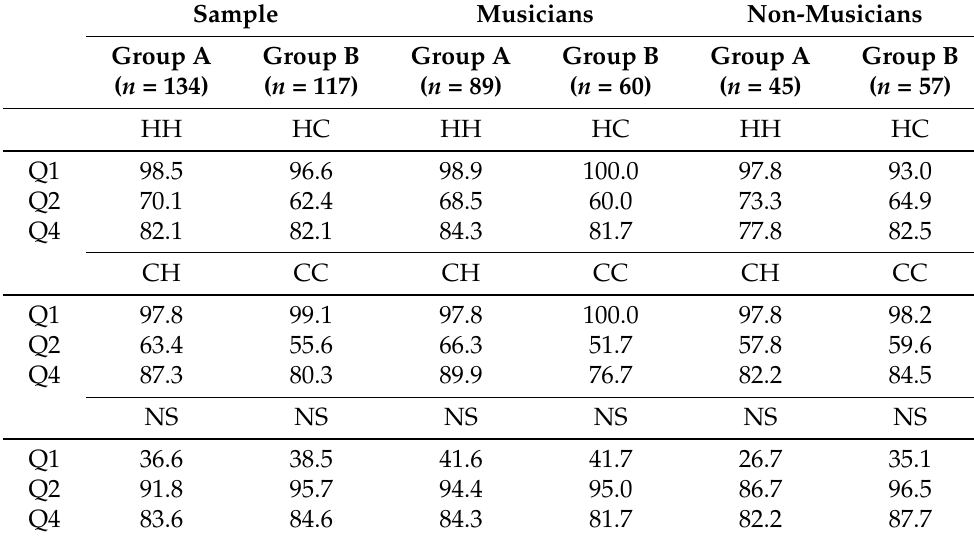
Table 4. Results of the yes/no questions proposed in Phase I of the experiment. The percentages of “yes” are shown. Q1: Would you say that what you have listened to is music? Q2: Does it